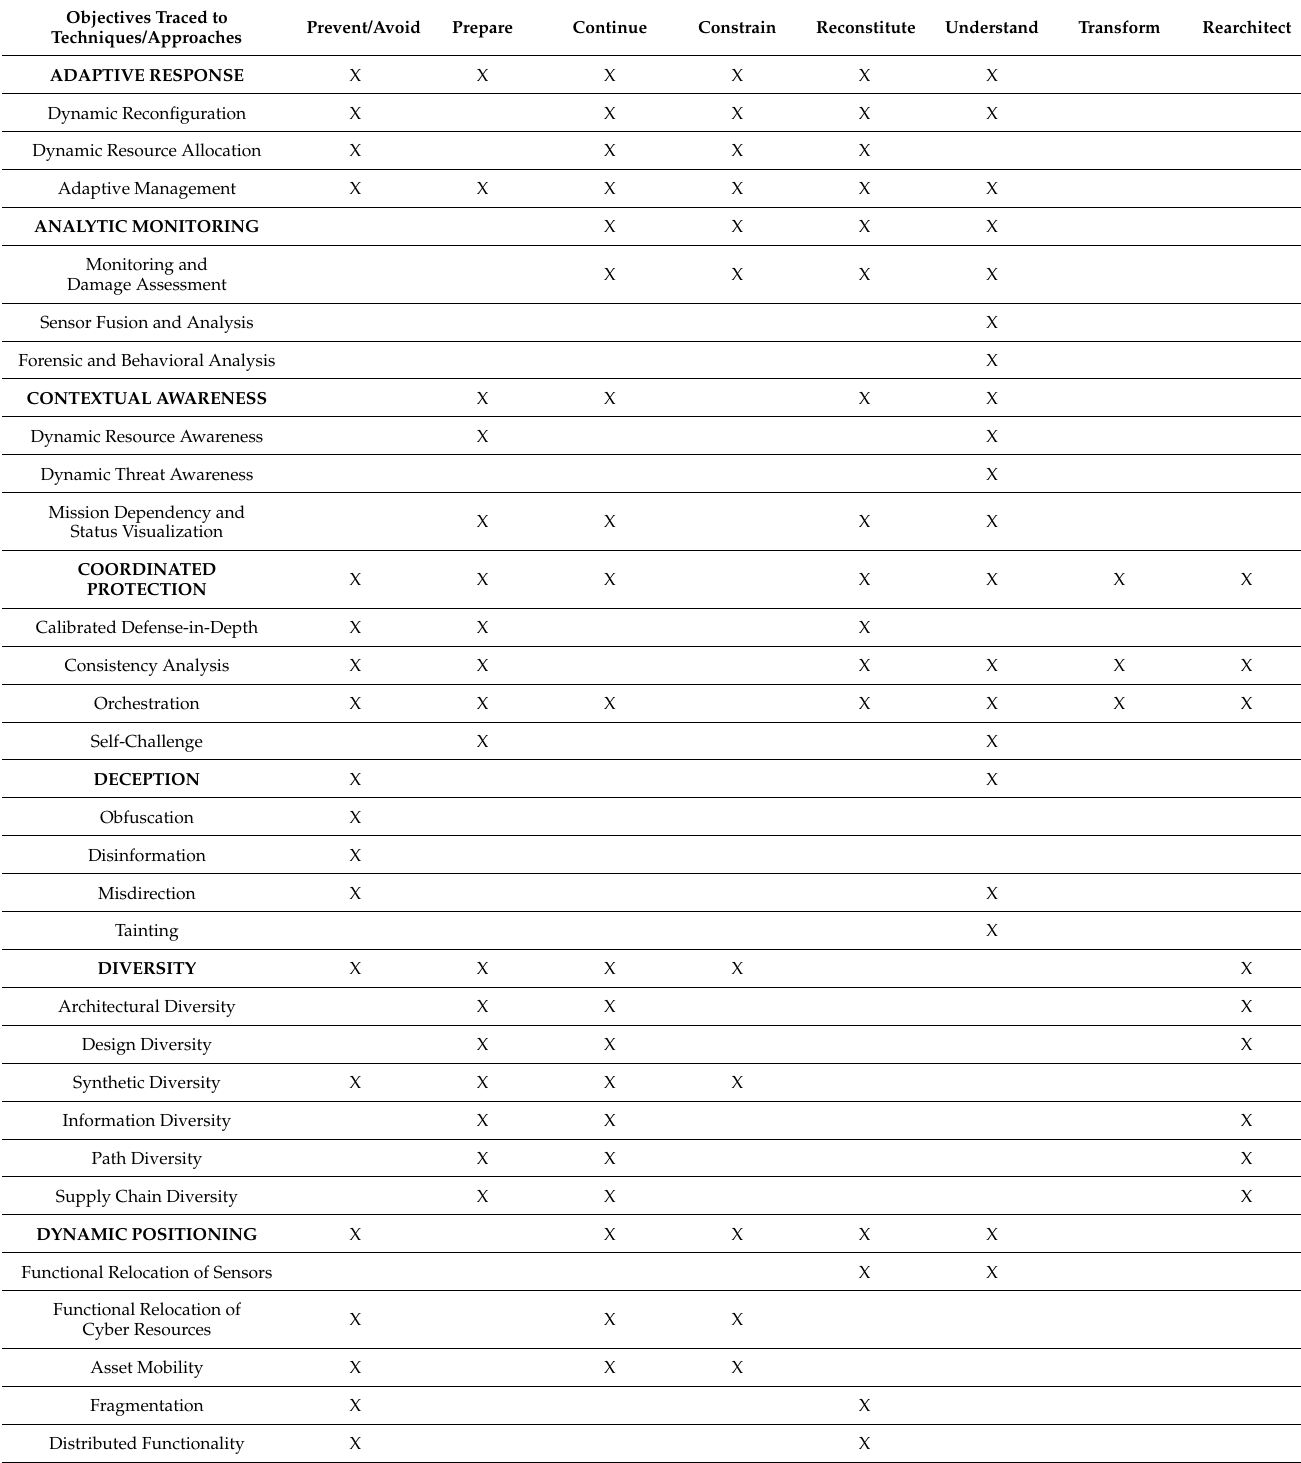
Table 3. NIST 800-160 Vol. 2 Table D-13: cyber resiliency techniques and implementation approaches supporting cyber resiliency